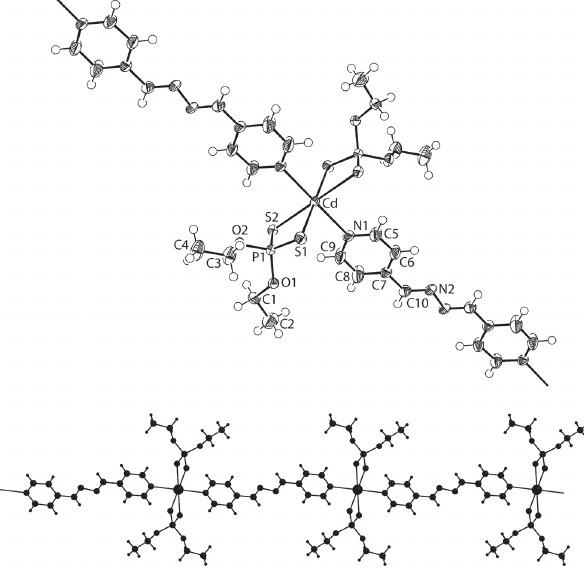
Table 1 contains crystallographic data and Table 2 contains the list of the atoms including atomic coordinates and dis- placement parameters.